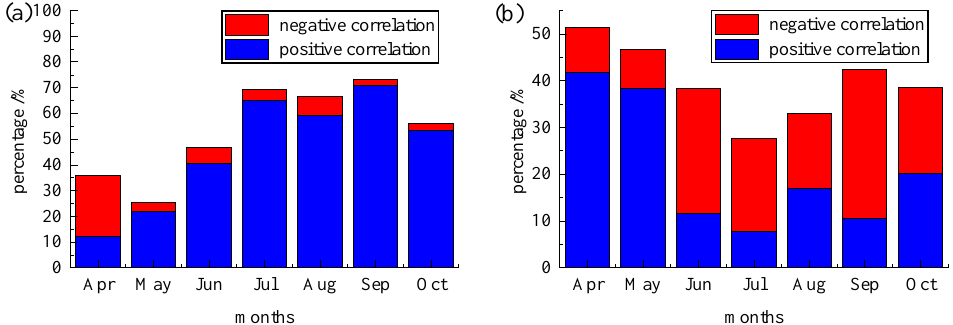
Figure 15. Percentage of significant pixels obtained by linear regression of NDVI and precipitation/temperature in different months. ( a ) precipitation; ( b ) temperature.